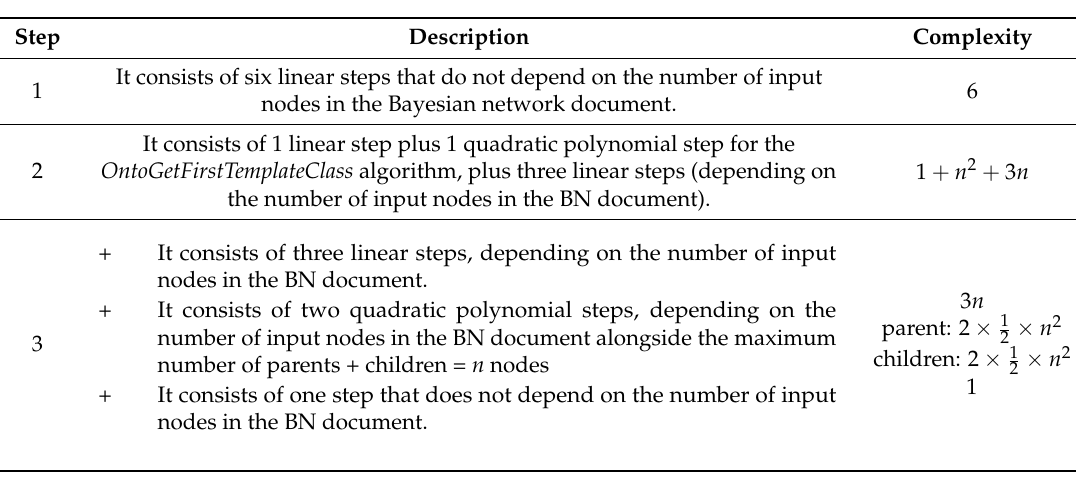
Table 2. Complexity analysis of the MergeBN